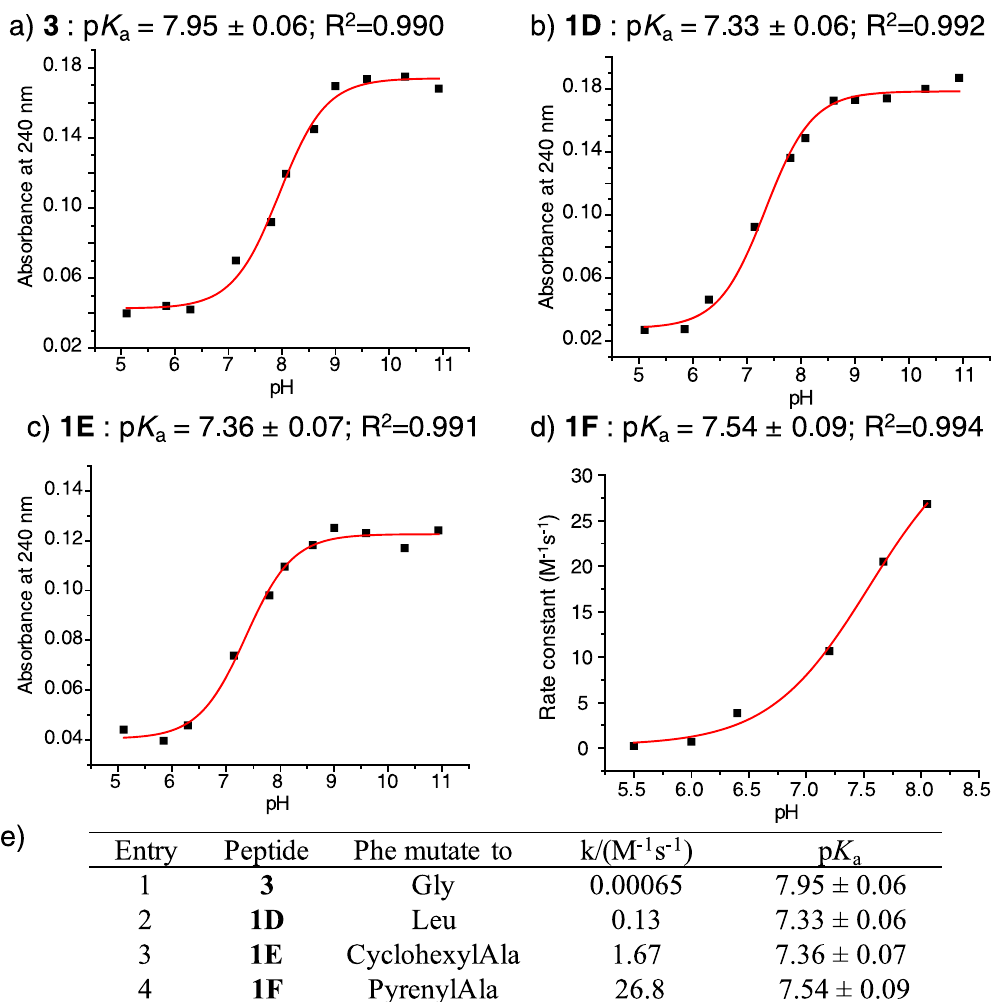
Figure 2. The cysteine p K a in π -clamp mutants are reduced. Absorbance at 240 nm across different pHs were measured to determine the cysteine p K a in peptide 3 ( a ), 1D ( b ) and 1E ( c ). ( d ) Rate constants for the reaction between 1 F and 2 were measured at different pHs to determine cysteine p K a in peptide 1 F . ( e ) Summary of p K a and the reaction rates of π -clamp